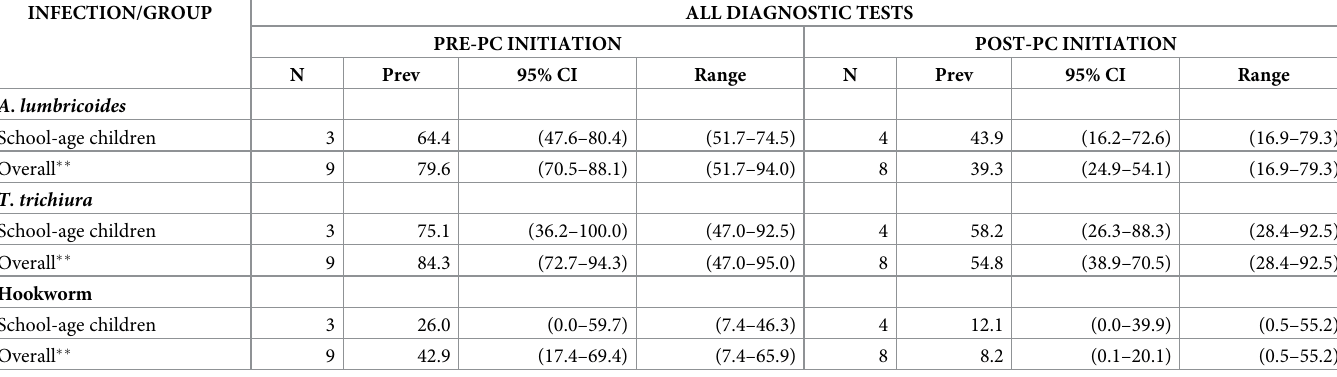
Table 3. Meta-analyses of prevalence of A . lumbricoides , T . trichiura , and hookworm by preventive chemotherapy status and population group in Leyte province (1955–2015).